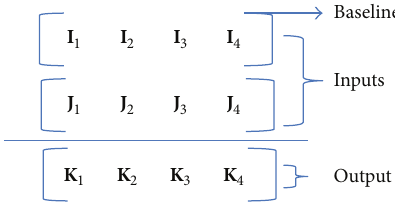
Figure 1: Received inputs and output during